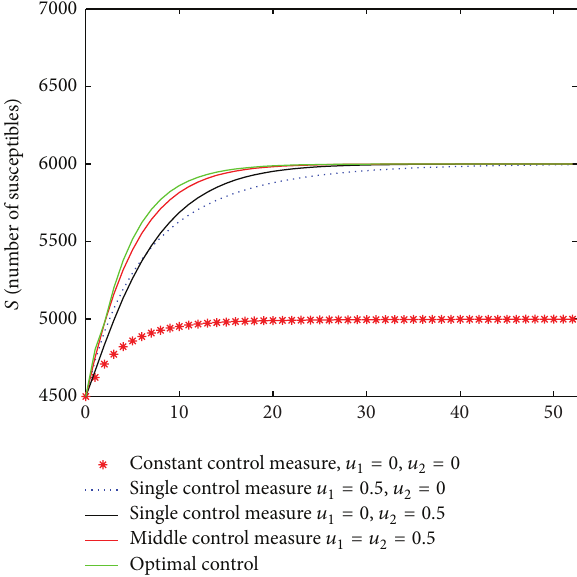
Figure 11: Number of the susceptibles when we choose the weights in objective function are 𝑐 1 = 10 4 , 𝑐 2 = 10 2 and under different optimal control strategies, that is, (1) without control: 𝑢 1 = 𝑢 2 = 0 ; (2) single control: 𝑢 1 = 0.5 , 𝑢 2 = 0 ; (3) single control: 𝑢 1 = 0 , = 0.5 ; (4) middle control: 𝑢 = 𝑢 = 0.5 ; (5) optimal control: 𝑢 2 1 2 = 𝑢 ∗ 𝑢 = 𝑢 ∗ 𝑢 1 2 1 , 2